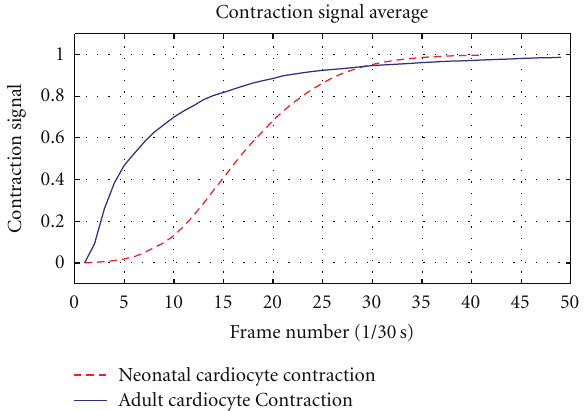
Figure 10: Solid line: average adult cardiocyte contraction mea- sured using image processing-based techniques recently proposed in [17]. Dashed line: average neonatal cardiocyte contraction mea- sured using the proposed methodology. Results are in accordance with the expected outcomes given the marked di ff erences in the development of both cell types and their di ff erence in Ca 2+ han- dling.